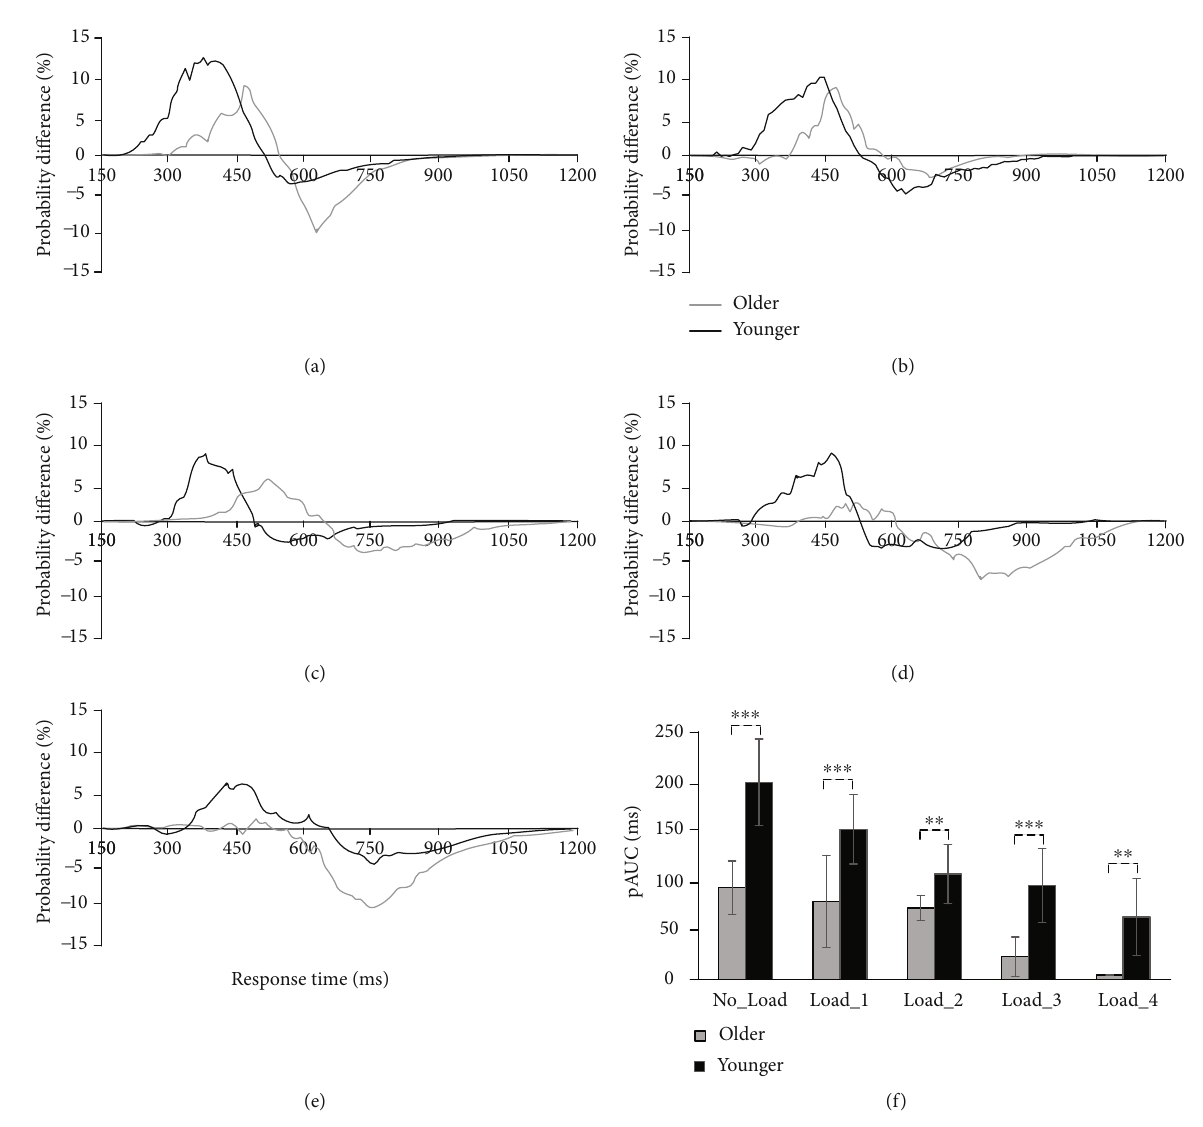
Figure 3: The comparison of probability di ff erences between older and younger adults in the (a) no-attentional-load, (b) attentional load_1, (c) attentional load_2, (d) attentional load_3, and (e) attentional load_4 conditions; the positive area under the curve (pAUC) was decreased with the addition of attentional load, and AVI was lower in older adults than in younger adults (f). ∗∗ p < 0 : 01 and ∗∗∗ p < 0 : 001 . Table 2: The time window (ms), peak latency (ms), peak bene fi t (%), and area under the curve (pAUC, ms) for older and younger adults under each attentional load